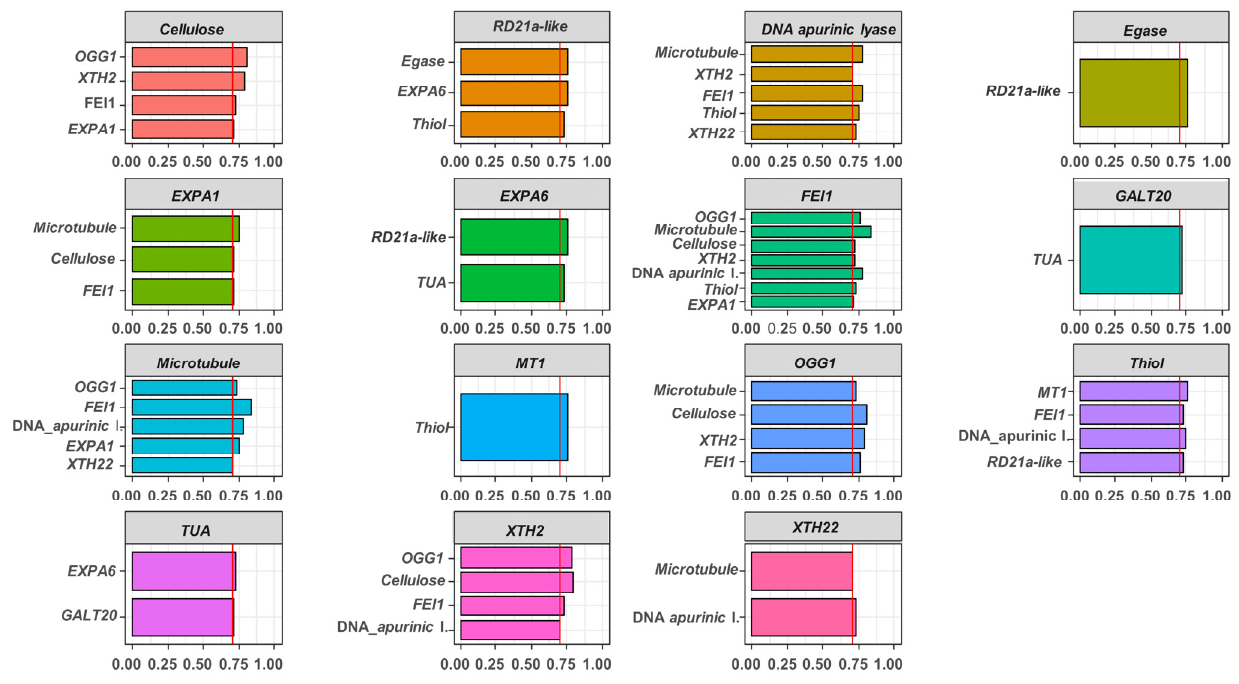
Figure 6. Correlation between genes analyzed during germination sensu stricto in seed embryos of two cultivars and their respective lots. Spearman method was used to obtain correlation coefficient ( r ) ( p ≤ 0.05). Only values of r > 0.70 were presented. N-glycosylase/DNA lyase OGG1 ( OGG1 ), DNA